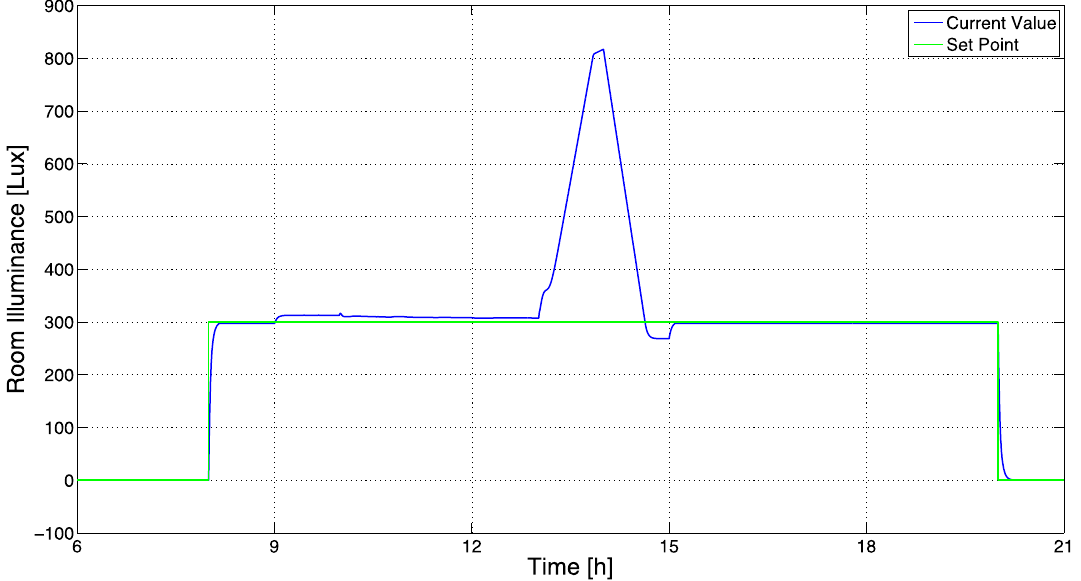
Figure 34. Control results (second scenario, modified control system, Energy Saving policy): room illuminance (CV).